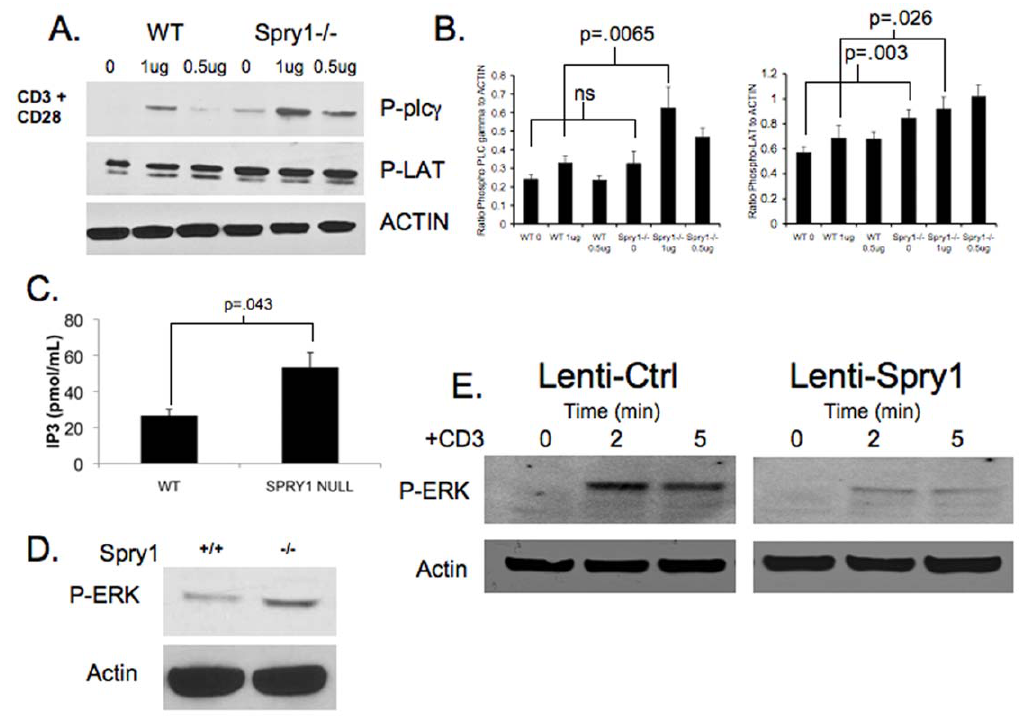
Figure 5. Spry1 null CD4 + T cells have enhanced TCR signaling. A. Western blot analysis of PLC- c and LAT phosphorylation in wild type and Spry1 flox/flox Lck cre CD4 + T cells following ten-minute stimulation with anti-CD3 and anti-CD28. B. Graphical representation of Phospho-PLC c and Phospho-LAT levels as measured by densitometry presented as ratio of signal to Actin levels. C . IP3 levels in wild type and Spry1 null CD4 + T cells following five-minute stimulation with anti-CD3. D. Western blot analysis of ERK phosphorylation in wild type and Spry1 flox/flox Lck cre CD4 + T cells following 5 minute stimulation with anti-CD3. E. Western blot analysis of ERK phosphorylation in control vector or Spry1 overexpression vector transduced jurkat T cells following 2 and 5 minute stimulation with anti-CD3. Error bars represent one standard deviation of the mean. P values indicate statistical significance by student t-test. All experiments were performed at least three times. Data are representative of 3 mice per group.